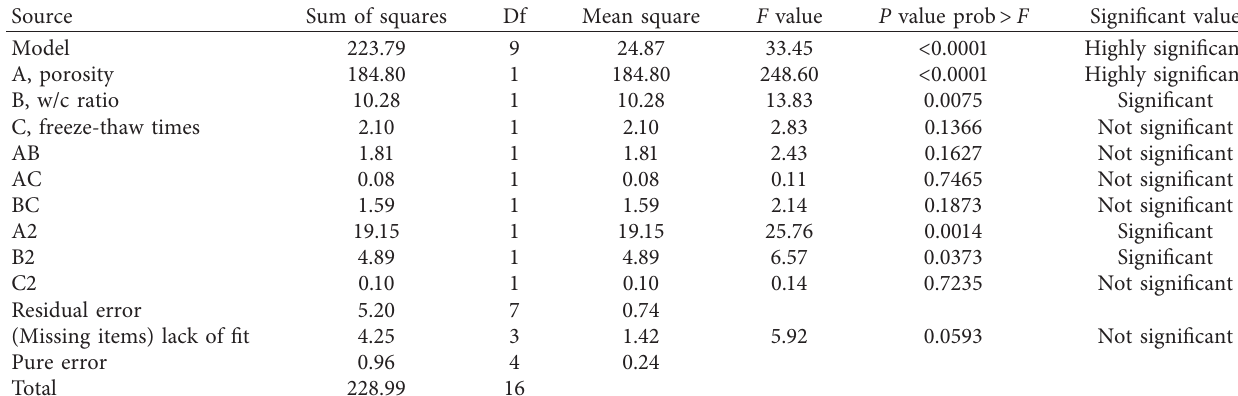
Table 11: Regression equations for the analysis of variance and significance